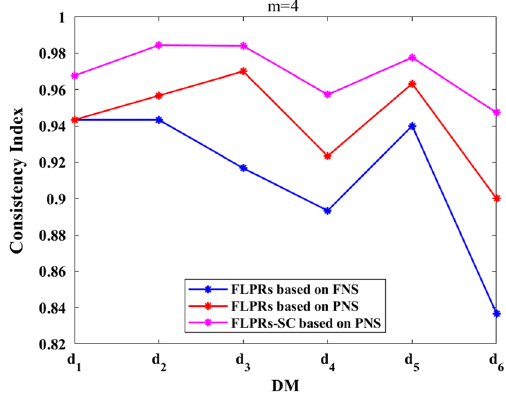
Fig. 2 Consistency indexes of DMs under different approaches